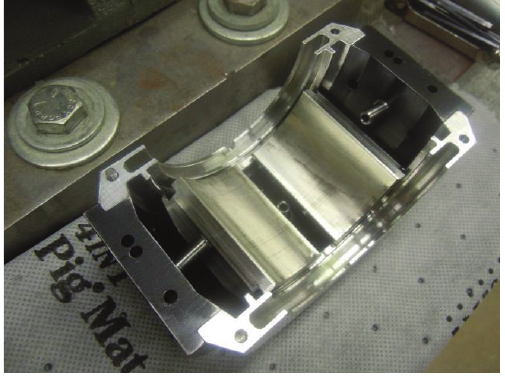
Figure 3: Photo of bearing